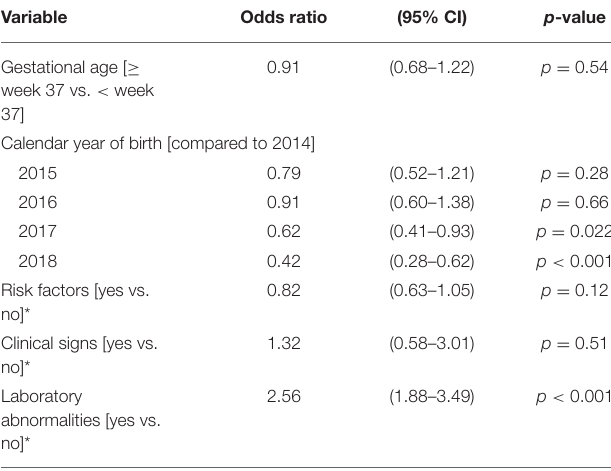
TABLE 5A | Ordered logistic regression: duration of antibiotic therapy by gestational age, calendar year of birth, risk factors, clinical signs, and laboratory abnormalities.